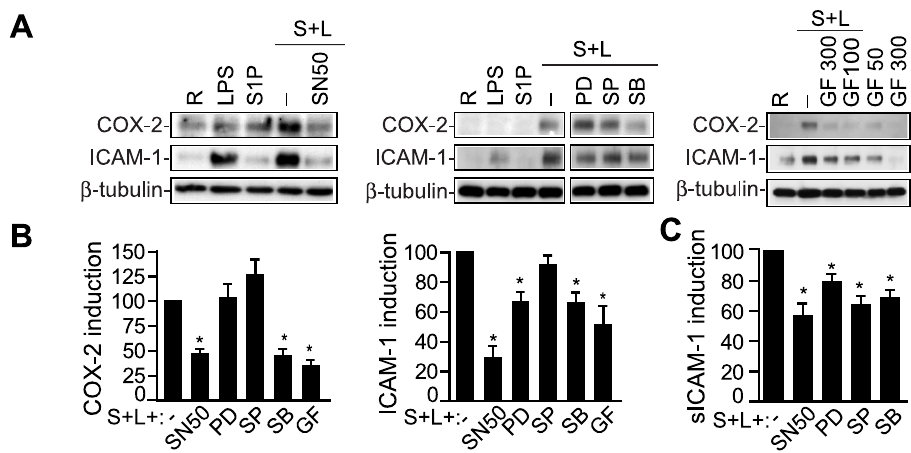
Figure 6. Signaling routes implicated in the cooperative effect. A–B) AVIC were pre-treated with the indicated drugs, activated for 12 h, and analyzed as in Figure 4. Representative immunoblots of AVIC lysates and densitometry data show inhibition of the cooperative effect on COX-2 and ICAM-1 (100% value) by NF- k B-SN50 and MAPK inhibitors (n=8). C) Supernatants were analyzed for sICAM-1 as in Figure 3 (n=6). GF indicates 300 nM GF109203X; PD, 50 m M PD98059; SB, 10 m M SB203580; S + L, S1P + LPS; SN50; 50 m g/mL NF- k B SN50; SP, 10 m M SP600125. * p , 0.05 vs. S1P + LPS (100% value).